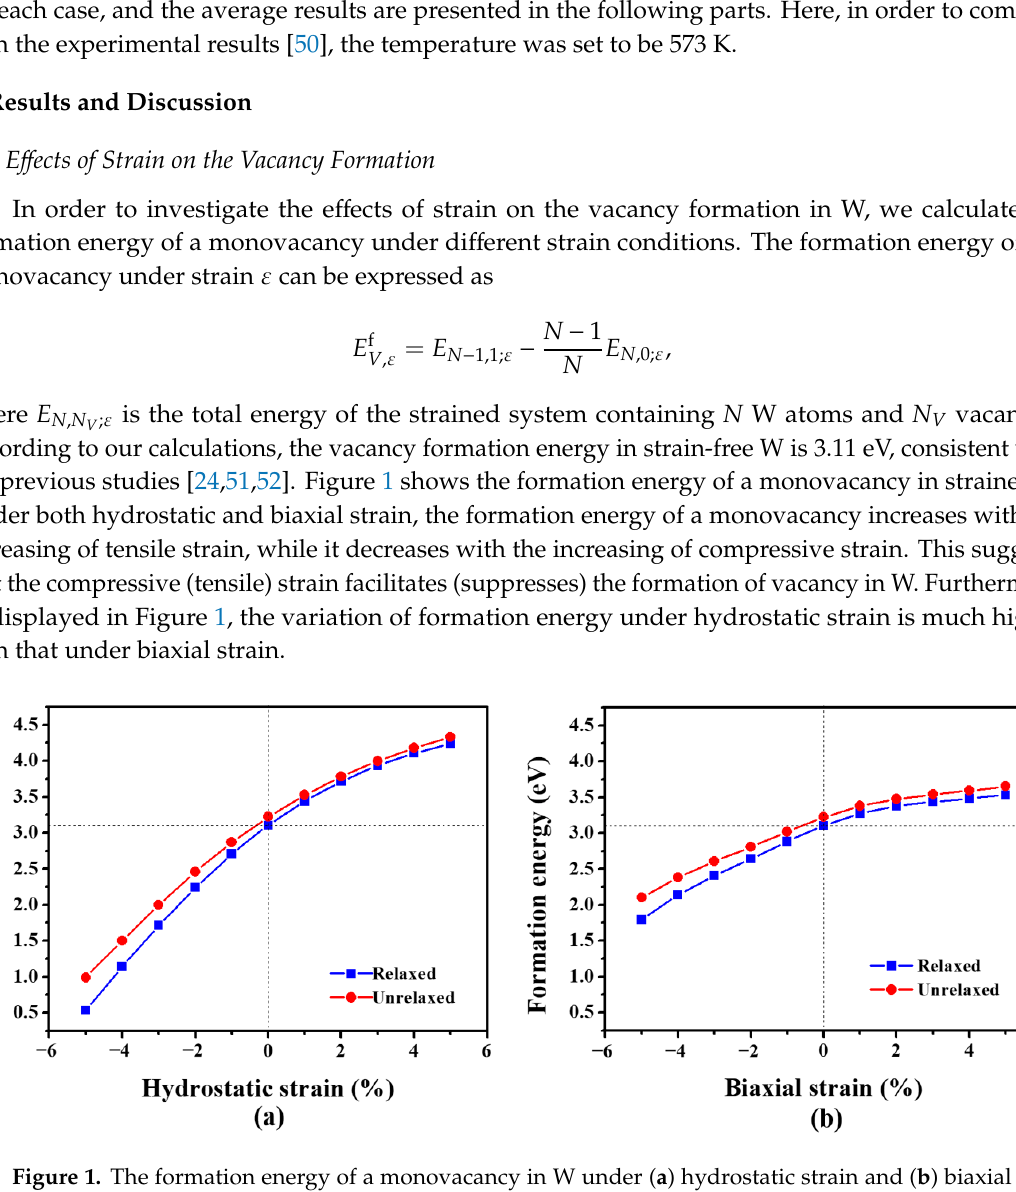
Figure 1. The formation energy of a monovacancy in W under ( a ) hydrostatic strain and ( b ) biaxial strain. The atoms are either fully relaxed (blue square) or fixed (red circle) in the calculations.